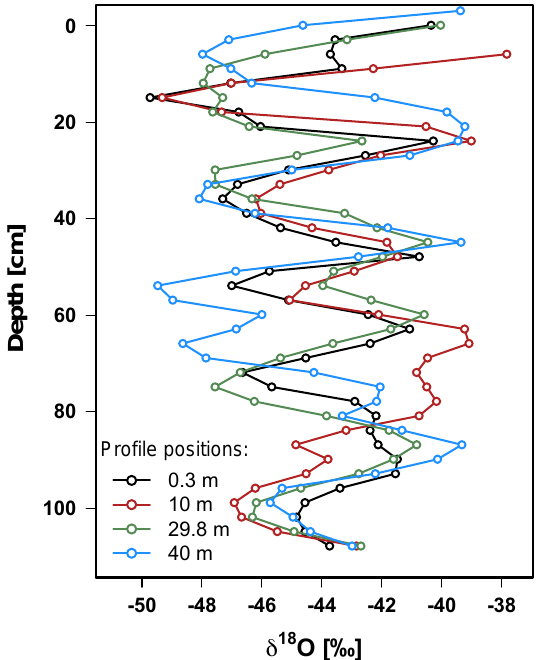
Figure 3. The four δ 18 O profiles obtained from trench T2 displayed on absolute coordinates.